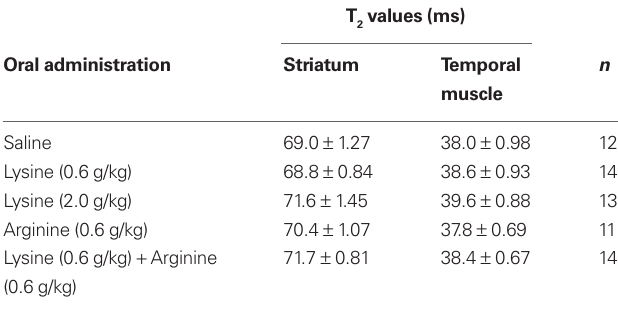
The ‘n’ represents numbers of experiments.